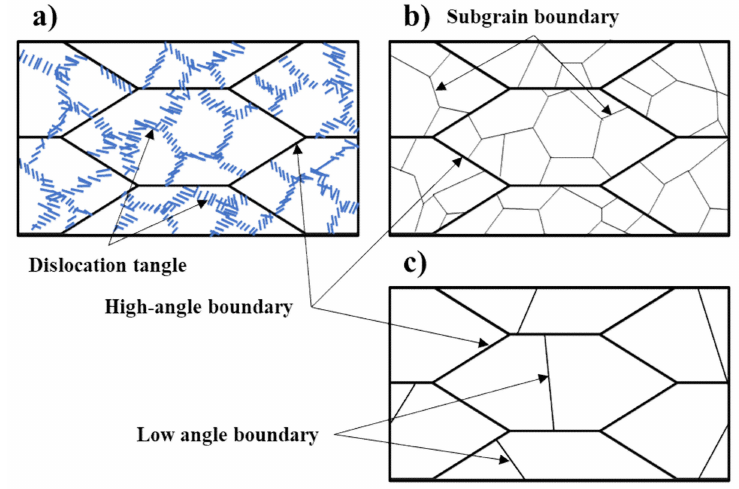
Figure 15. Schematic diagram for formation and coalescence of sub-grains during annealing. ( a ) cold- rolled structure with low plastic deformation, ( b ) formation of subgrain during recovery and ( c ) coa- lescence of the subgrain by subsequent annealing.